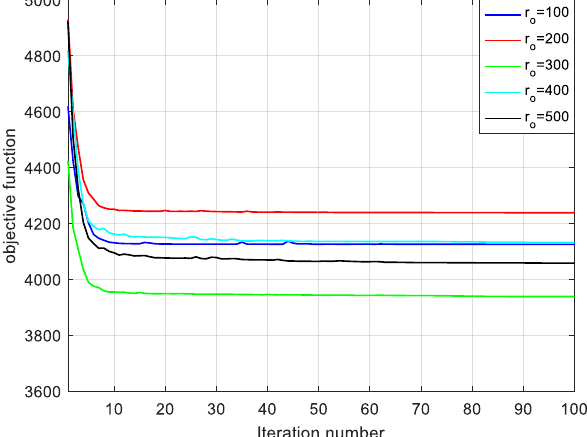
Figure 3. The Iterative process of the Genetic Algorithm (GA).